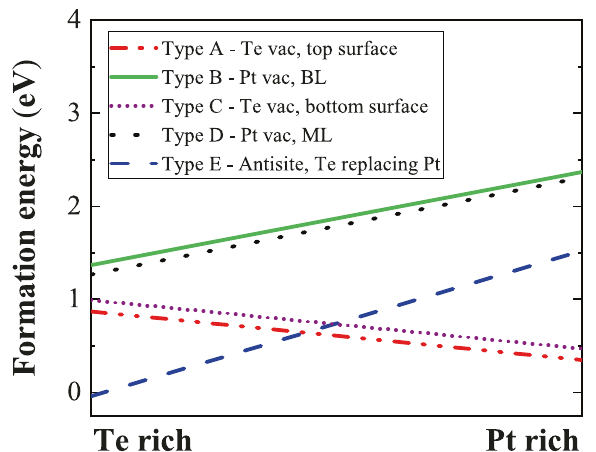
Fig. 7 DFT-calculated formation energies for selected defect types in PtTe 2 . Te vacancy has the lowest formation energy. The same plot including some additional less-probable types of defects is shown in Supplementary Fig.